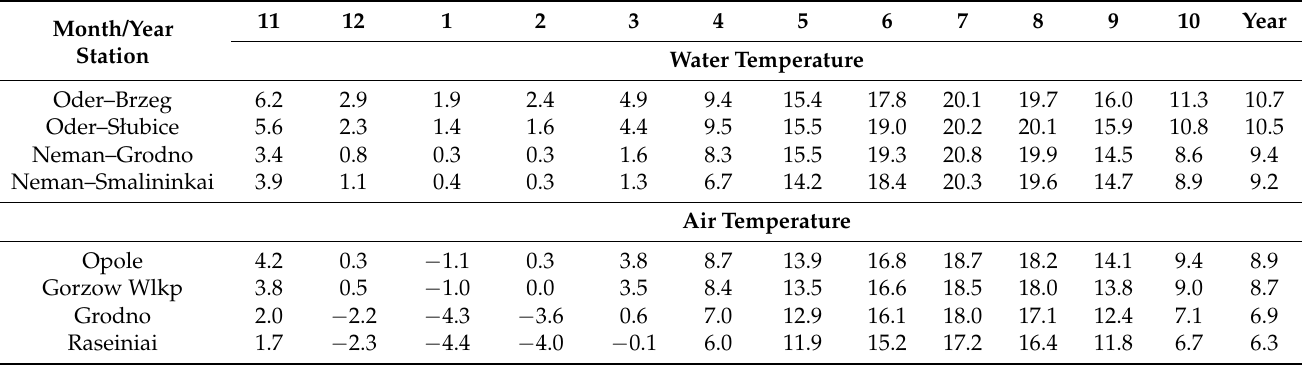
Table 2. Mean monthly and annual water and air